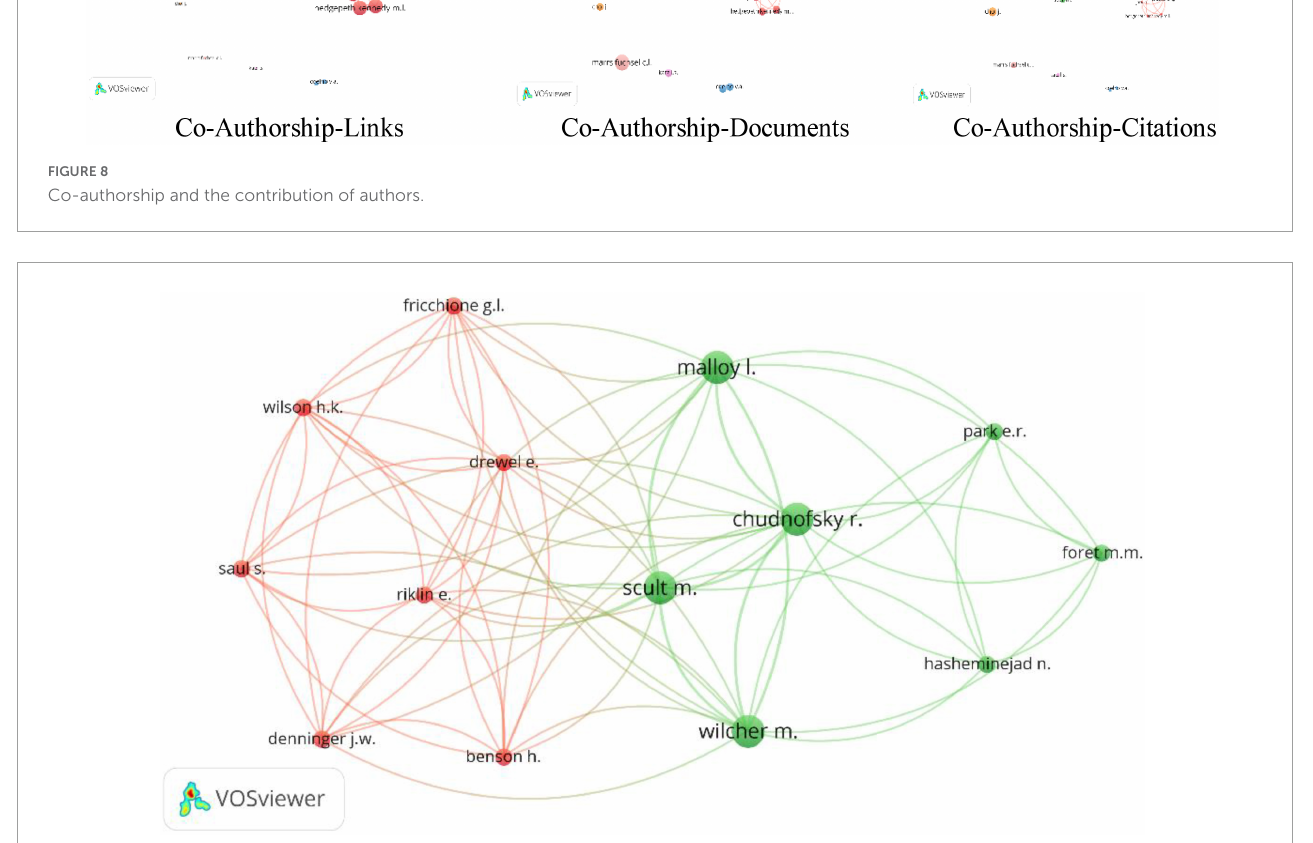
FIGURE9 Author contributions to publications on the relationship between curriculum and